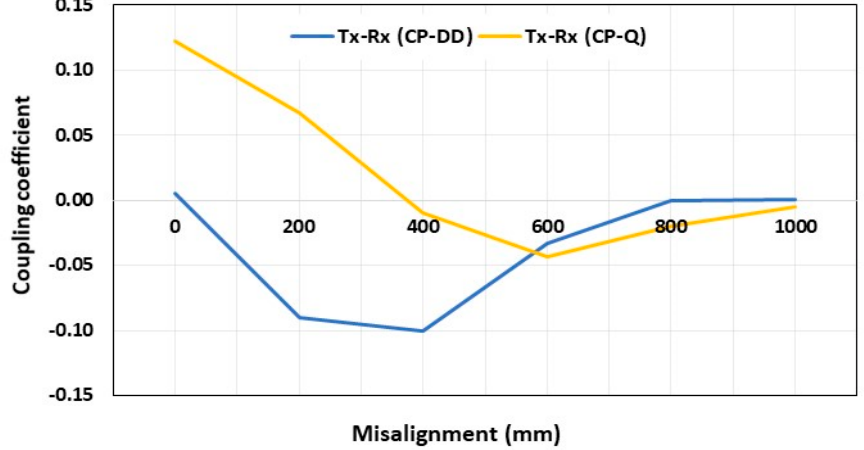
Figure 24. Variation of the coupling coefficient (k) as a function of the misalignment along the y-axis for the CP–DDQ configuration.